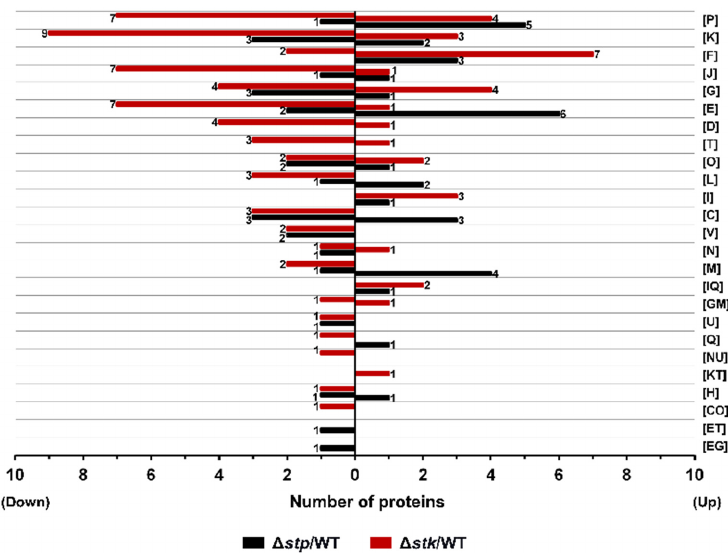
Figure 6. COG enrichment of the differentially expressed proteins in Δ stp and Δ stk strains. The differentially expressed proteins (fold change > 1.5, p value < 0.05) were analyzed with the EggNOG v5.0 database (http://eggnog5.embl.de/#/app/home (accessed on 25 June 2021)). [P] Inorganic ion transport and metabolism; [K] Transcription; [F] Nucleotide transport and metabolism; [J] Transla- tion, ribosomal structure and biogenesis; [G] Carbohydrate transport and metabolism; [E] Amino acid transport and metabolism; [D] Cell cycle control, cell division, chromosome partitioning; [T] Signal transduction mechanisms; [O] Posttranslational modification, protein turnover, and chaper- ones; [L] Replication, recombination and repair; [I] Lipid transport and metabolism; [C] Energy pro- duction and conversion; [V] Defense mechanisms; [N] Cell motility; [M] Cell wall/membrane/enve- lope biogenesis; [IQ] Lipid transport and metabolism, Secondary metabolites biosynthesis, transport, and catabolism; [GM] Carbohydrate transport and metabolism, Cell wall/membrane/en- velope biogenesis; [U] Intracellular trafficking, secretion, and vesicular transport; [Q] Secondary metabolites biosynthesis, transport, and catabolism; [NU] Cell motility, Intracellular trafficking, se- cretion, and vesicular transport; [KT] Transcription, Signal transduction mechanisms; [H] Coen- zyme transport and metabolism; [CO] Energy production and conversion, Posttranslational modi- fication, protein turnover, and chaperones; [ET] Amino acid transport and metabolism, Signal trans- duction mechanisms; [EG] Amino acid transport and metabolism, Carbohydrate transport and me- tabolism.